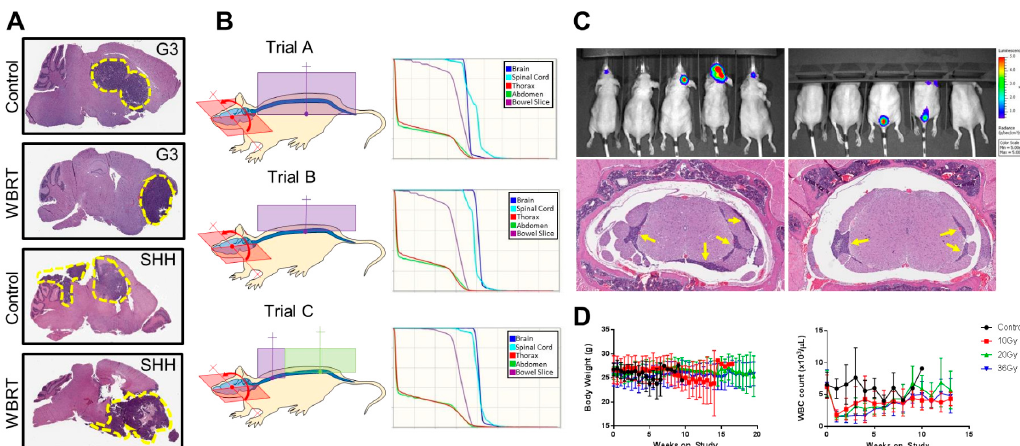
Figure 2. Preclinical modeling of craniospinal irradiation (CSI) of patient-derived orthotopic xenograft (PDOX) models of medulloblastoma. ( A ) Evidence of olfactory bulb metastasis in orthotopic xenograft mouse models of very-high-risk medulloblastoma when treated with non-image-guided fractionated cranial radiation therapy. Metastasis is indicated by dashed lines on sections stained with hematoxylin and eosin. ( B ) Schematic of three CSI treatment plans using the small animal radiation research platform (SARRP ® ) (left) and the associated dose (Gy; x-axis)–volume (percent; y-axis) histograms of indicated regions of interest (right). All mice received brain arc treatment ( − 90 ◦ , 90 ◦ ), but the spinal fields were varied by number of fields and isocenter placement to determine the optimal treatment plan. ( C ) Upper panels: Pattern-of-failure analysis using custom head shielding to increase spinal bioluminescence sensitivity, with spinal metastasis indicated in two mice in the far-right panel. Lower panels: Arrows indicate spinal metastasis on sections stained with hematoxylin and eosin. ( D ) Body weight and hematologic toxicity of murine PDOX CSI demonstrating tolerability with expected transient depressions in white blood cells. (Reprinted with permission from “Preclinical Modeling of Image-Guided Craniospinal Irradiation for Very-High-Risk Medulloblastoma”, Smith, et al. 2011 [78]; Elsevier publisher. All rights